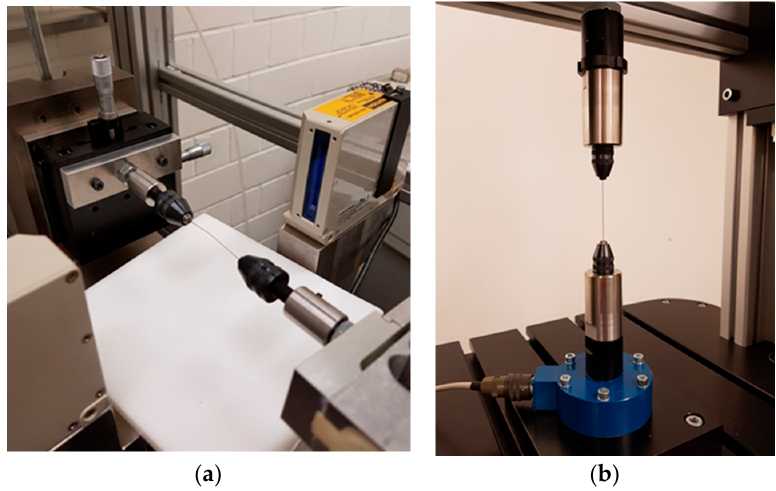
Figure 2. Pneumatic test system for fatigue tests: ( a ) MTS Tytron™ 250 and ( b ) DHM.